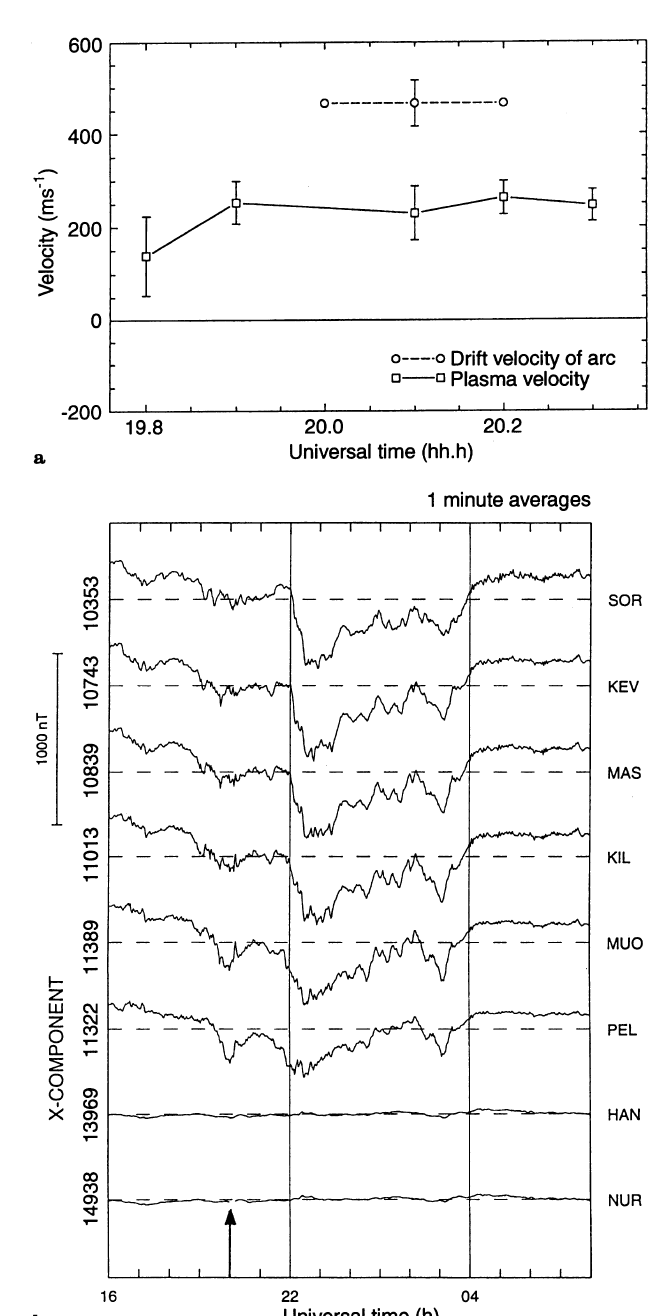
Fig. 4. a Comparison of arc drift velocity (indicated by broken line ) and plasma velocity in the same direction (indicated by continuous line ) for 28 October 1992. b X-component of magnetograms from the IMAGE network for 28–29 October 1992. The arrow indicates the time at which the arc